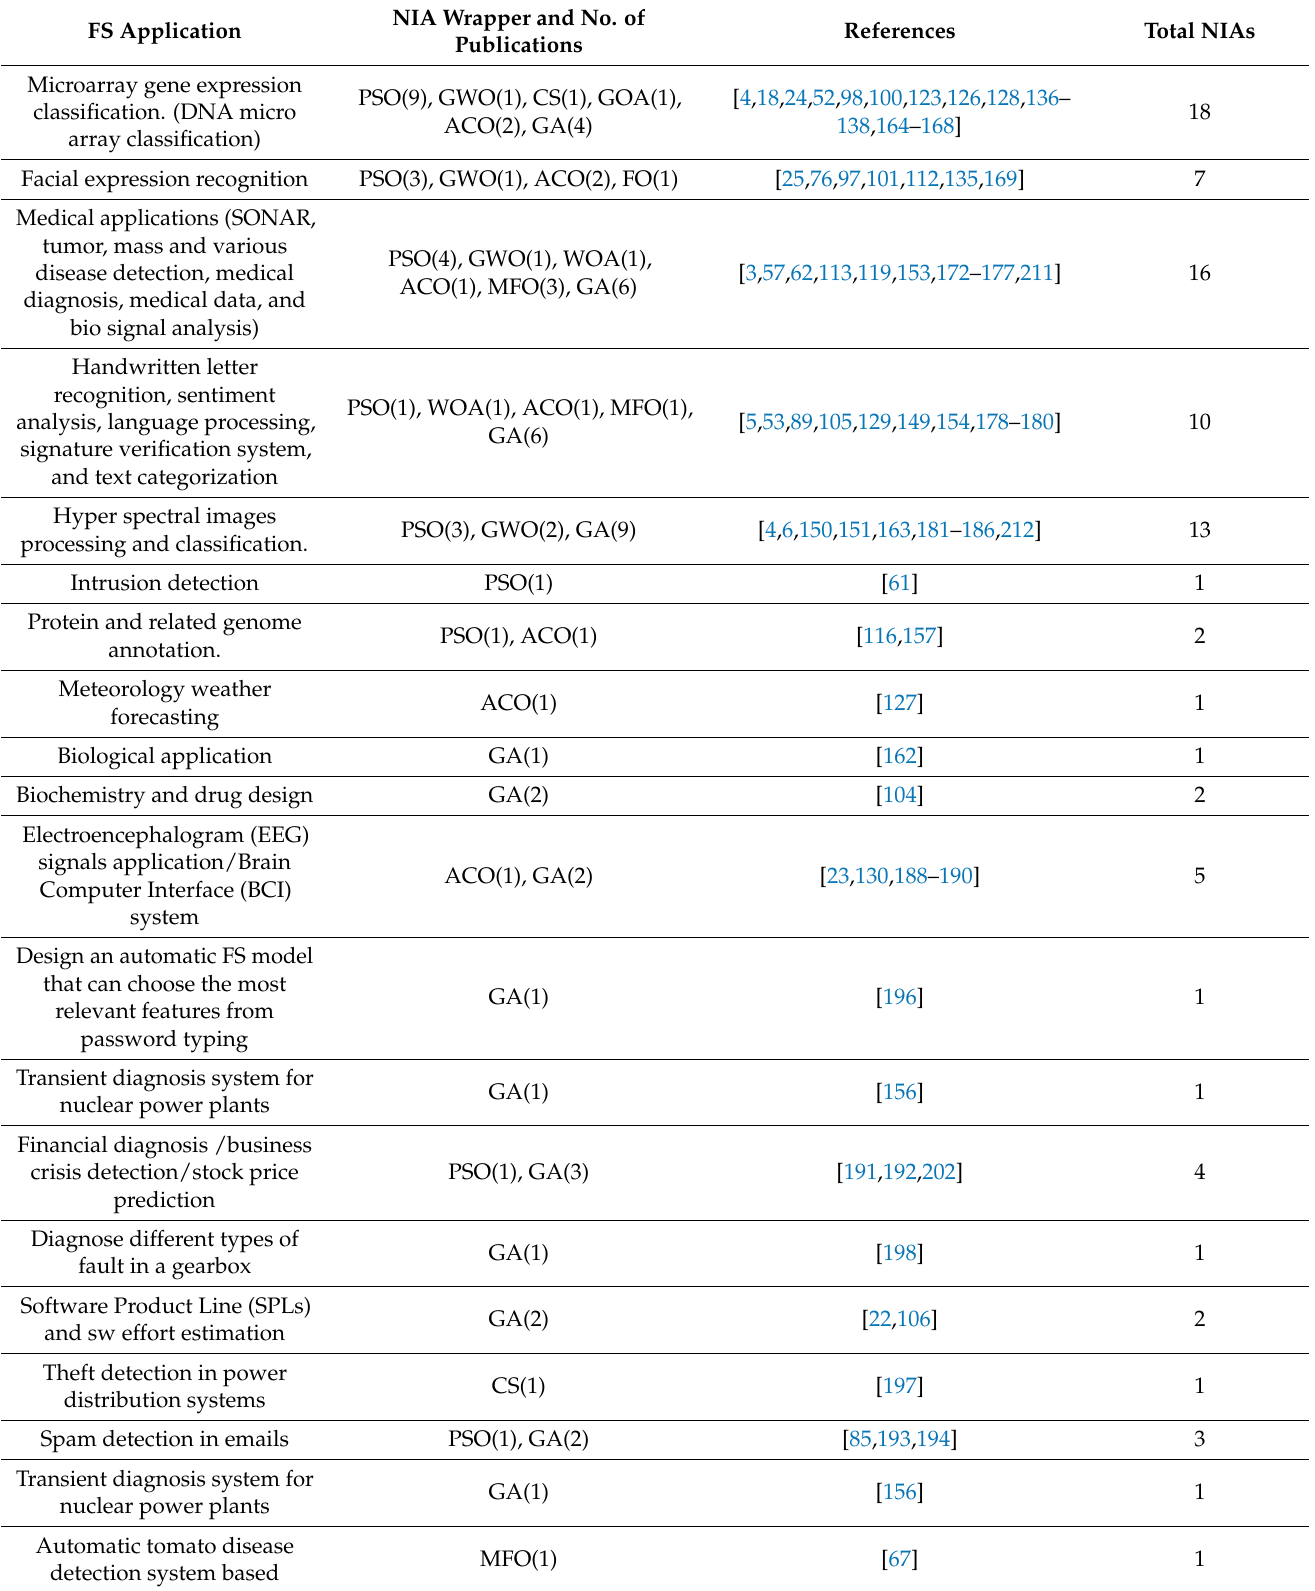
Table 6. Summary of main studies in the literature that applied modified NIAs-FS in